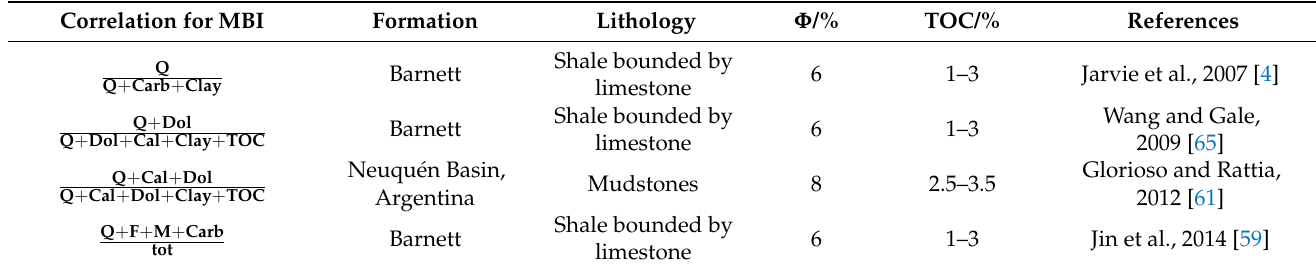
Table 4. MBI calculation